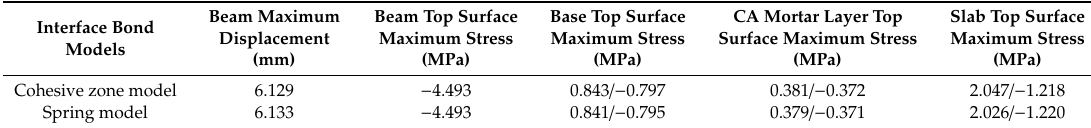
Table 7. Cohesion and spring model